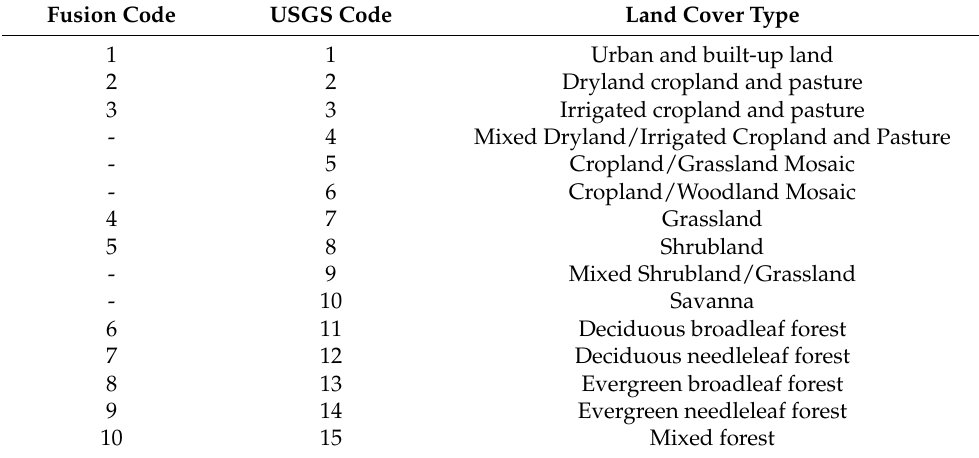
Table 1. The frame of discernment adopted in the study